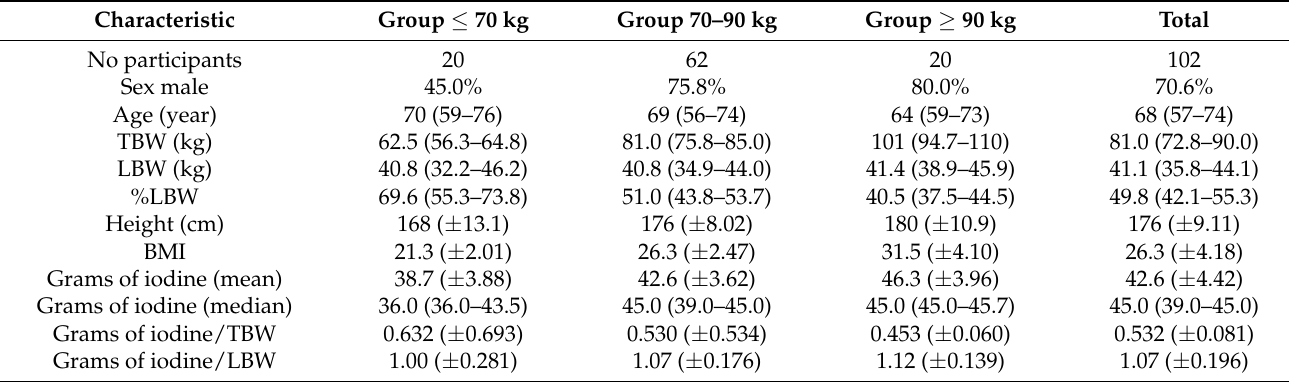
Table 1. Baseline characteristics. Normally distributed data are given as means with ± SDs and non-parametric data are given as medians with interquartile ranges (IQRs). TBW = total body weight; LBW = lean body weight in kilograms or percentage of lean body weight; BMI = body mass